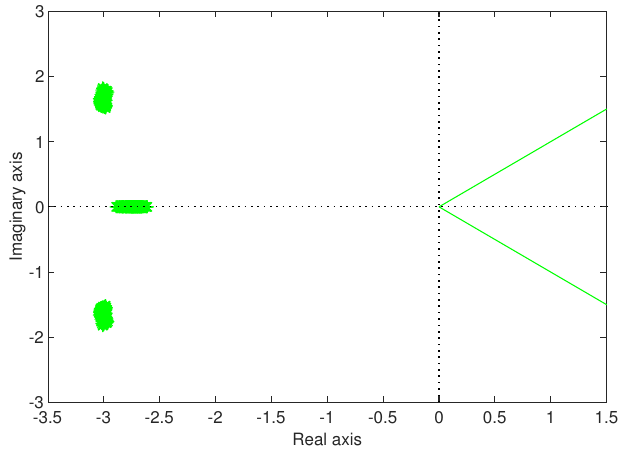
Figure 4. Eigenvalue perturbation region of system with order α = 1